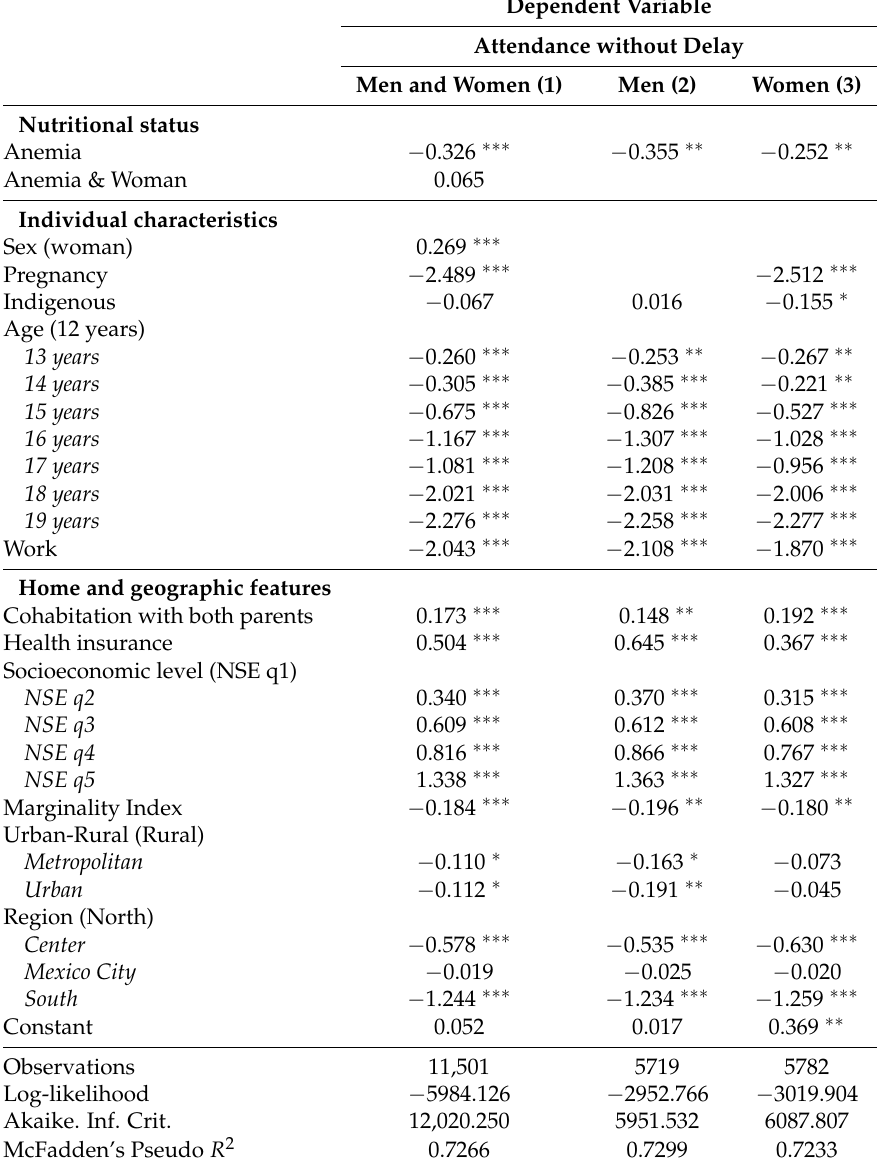
Table A2. Estimation of the marginal coefficient of the logistic regression of attendance without